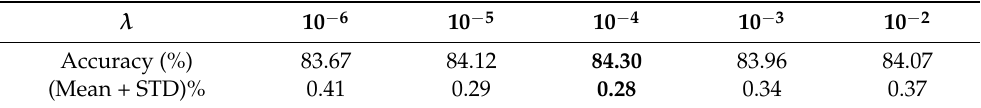
Table 2. Accuracy comparison with different methods adopted in XNOR-Net/ResNet-20 on CIFAR- 10. The best results are shown in bold.